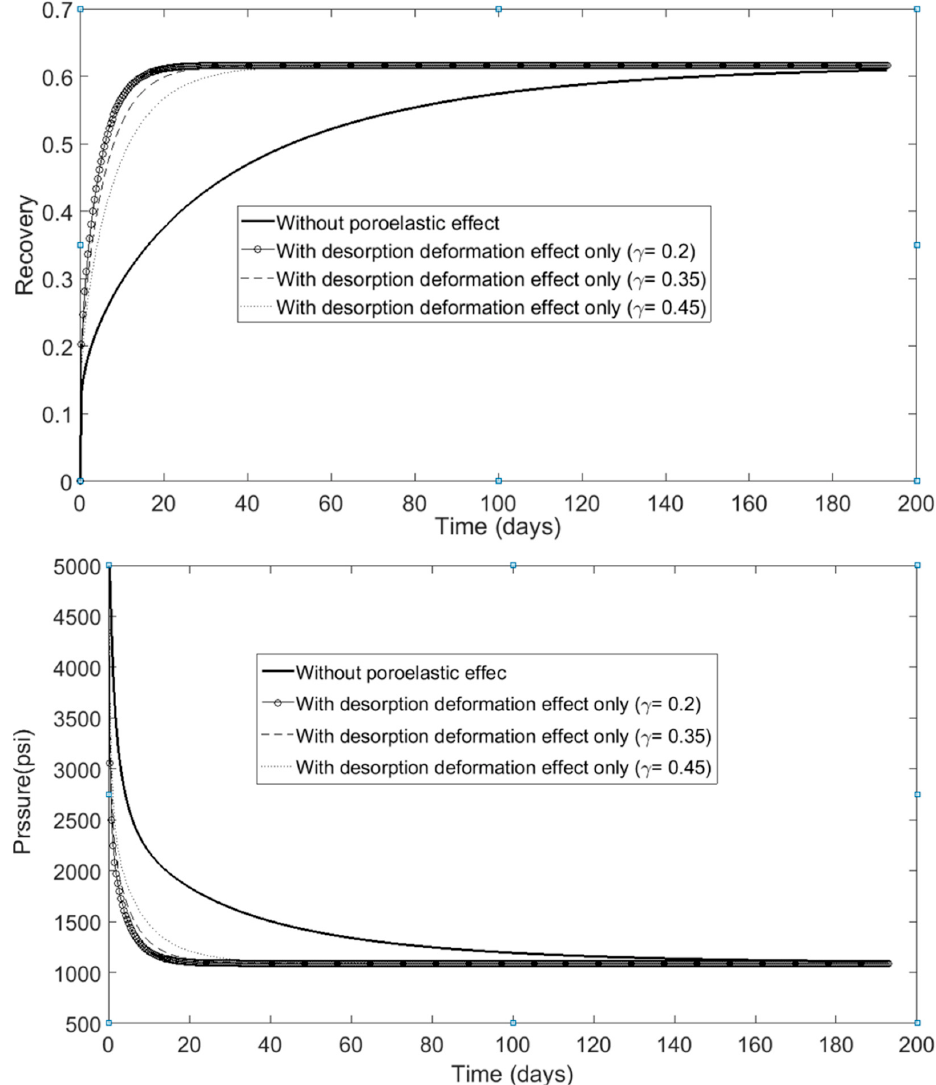
Figure 7. Impact of changes in Poisson’s ratio on pressure decay ( bottom ) and ultimate recovery ( top ).